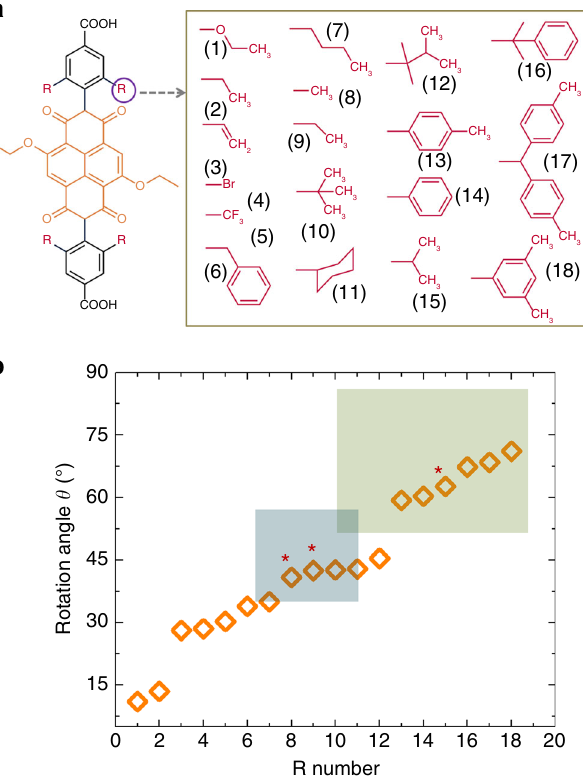
Fig. 2 Design of “ steric control unit ” . a Chemical structure of R-NDI(OEt) 2 and the possible R groups. b Plot of the rotation angle θ (calculated using GROMACS-2018.4 package, using a trimer model) vs the different R groups numbered as in a. The blue region is the borderline, and the green region corresponds to the possible J-aggregates. *Marked groups were synthesized and assembled as SURMOF